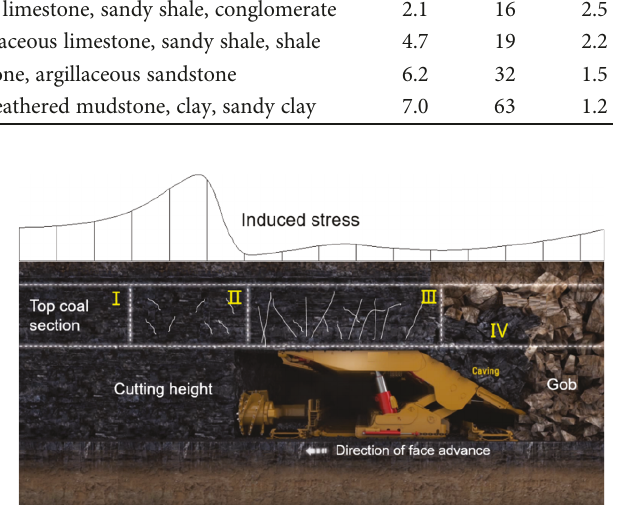
Figure 7: A conceptual model for longwall top coal status. I: the elastic zone, II: the deformed zone, III: the fractured zone, and IV: the broken zone.